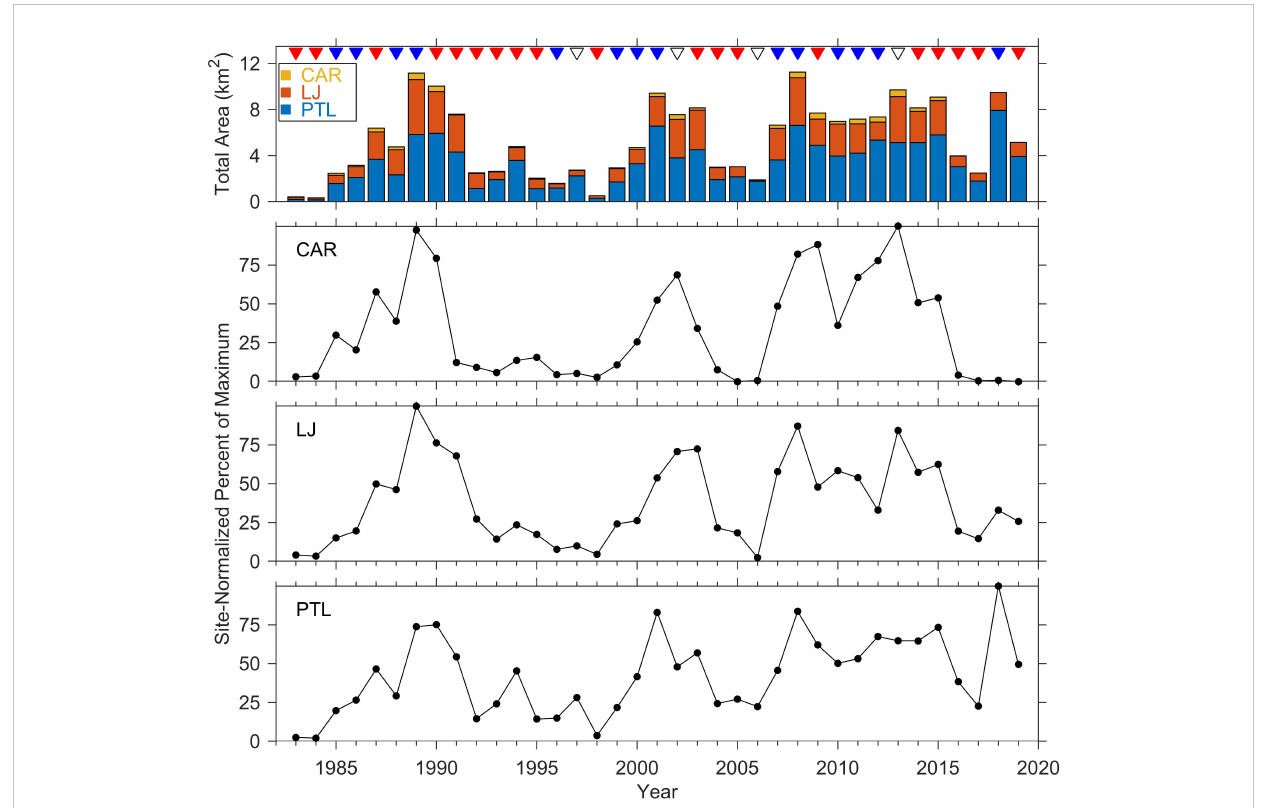
FIGURE 2 Sea surface kelp canopy cover at Cardiff (CAR), La Jolla (LJ), and Point Loma (PTL) kelp beds 1983 through 2019. Top panel shows total canopy area (km 2 ) color coded by site. Lower three panels show the yearly observations normalized by the maximum value observed across the time series within each site. Triangles at the top indicate years categorized by thermal patterns as warm (red), cold (blue), neutral (black) from the Multivariate ENSO Index; kelp cover are the maximum values recorded annually from quarterly aerial surveys. Data from (MBC Aquatic Sciences,